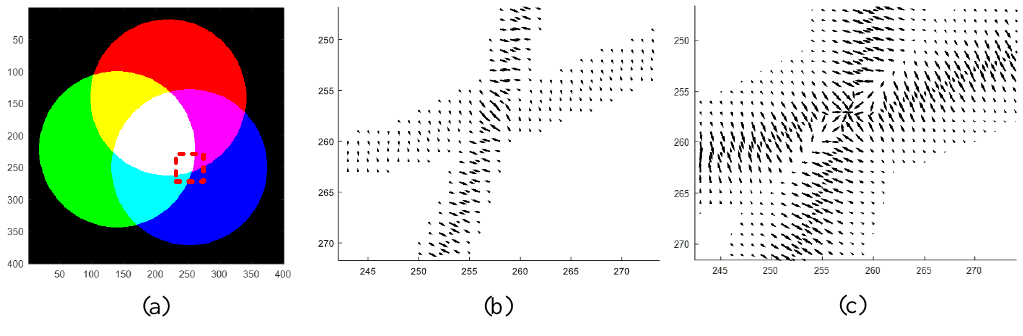
Figure 4. ( a ) original color image, ( b ) (cid:126) n obtained from Equation (1), and ( c ) (cid:126) n obtained from Equation